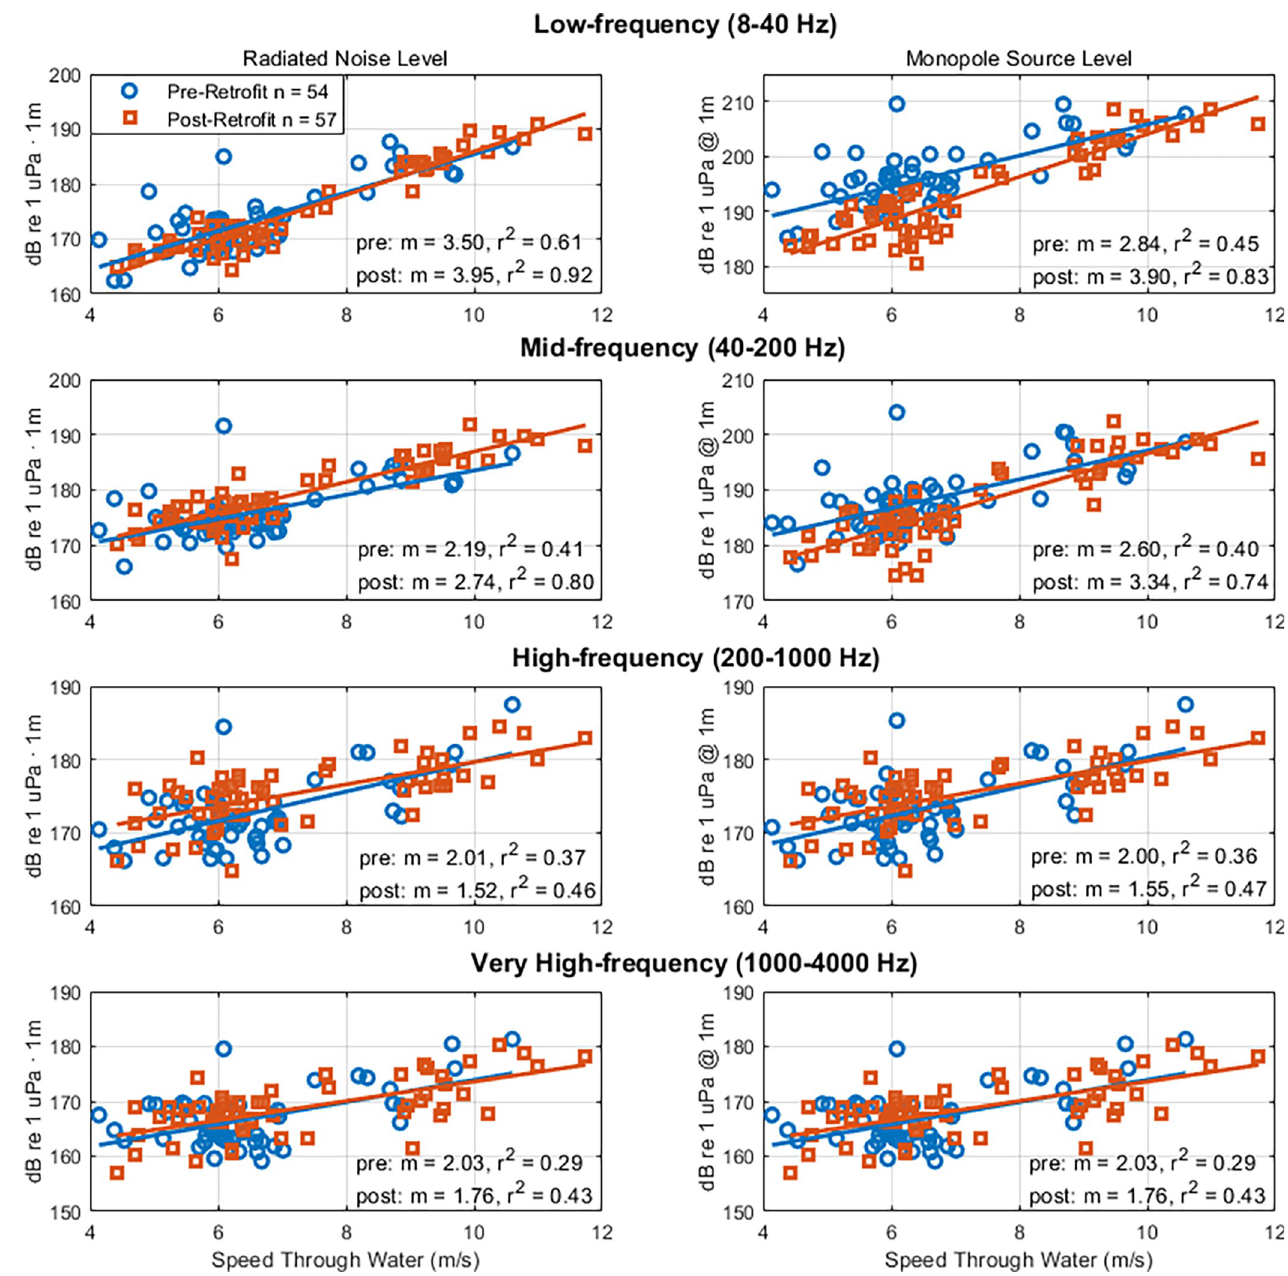
Fig 5. G-Class Maersk vessel noise levels in relation to speed through water. Broadband radiated noise level (left) and monopole source level (right) in relation to Speed Through Water for 111 G-Class Maersk transits pre-retrofit (blue circles) and post-retrofit (red squares) for low-, mid-, high-, and very high- frequency